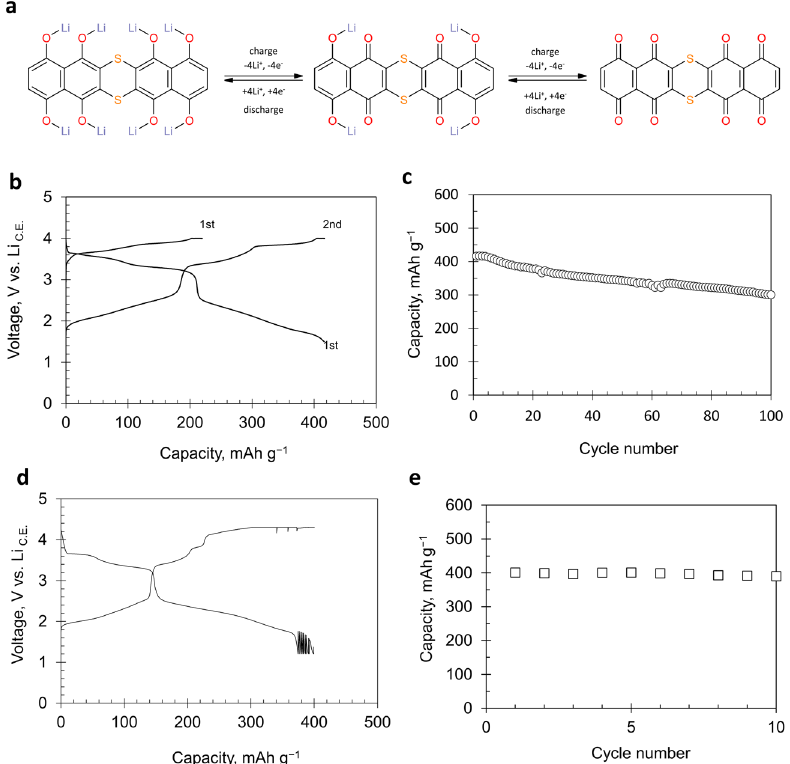
Fig. 5 Battery performance of the electrode using 2. a Conceivable charge/discharge reaction of 2 . b , c Typical charge/discharge curves during initial cycles ( b ) and cycle-life performance of the electrode incorporating 2 ( c ). (Current density: 20 or 50 mA g − 1 , Temperature: 30 °C.) d , e Charge/discharge curves ( d ) and cycle-life performance ( e ) of the high-content (83 wt%) electrode containing 2 . (Current density (discharge): 20 – 0.5 mA g − 1